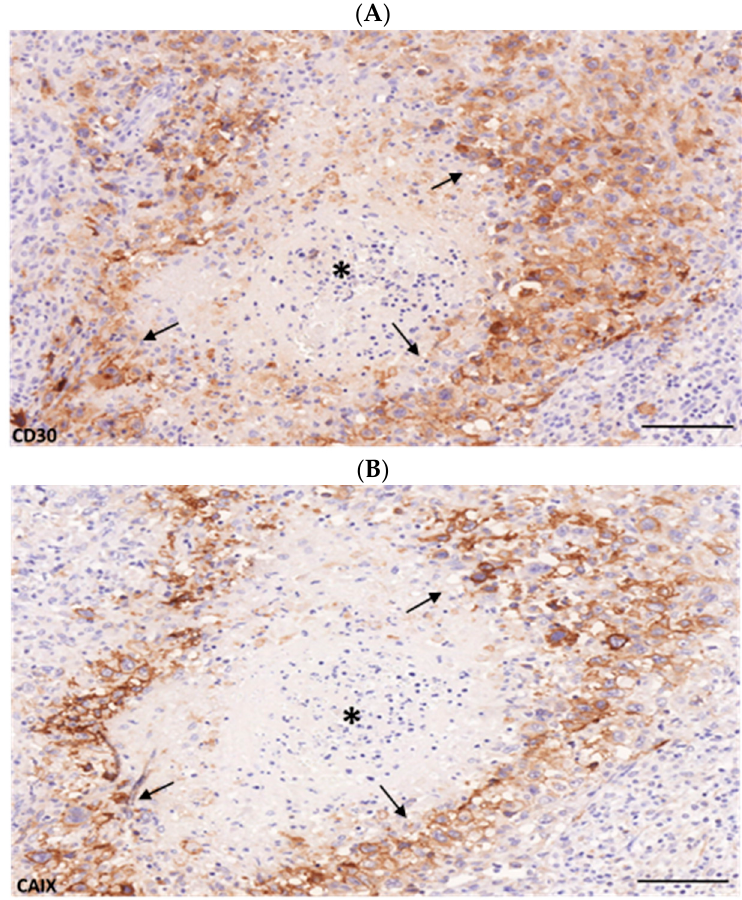
Figure 1. CD30 expression ( A ) representing Hodgkin–Sternberg–Reed (HRS) cells and partially carbonic anhydrase IX (CAIX) positivity ( B ) demonstrating hypoxia-related adaptation in a subset of lymphoma (cHL). Variable levels of membrane/cytoplasmic CAIX expression could be observed in